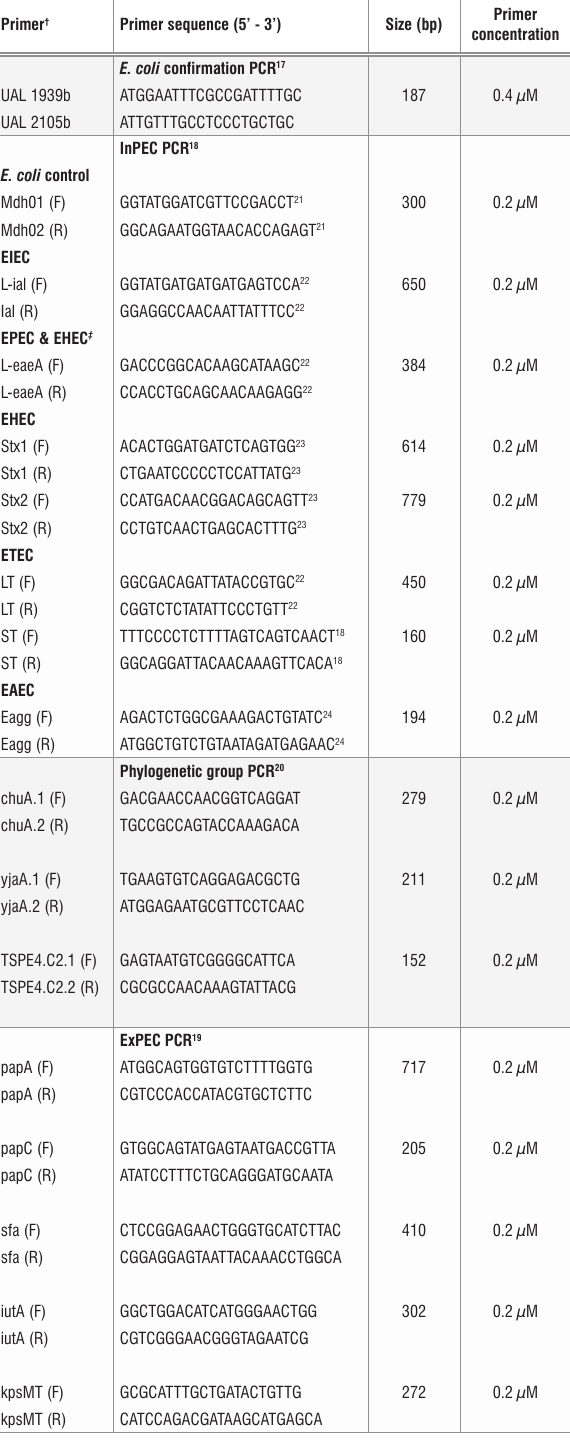
Primer sequences used for uid A, 17 triplex, 20 InPEC 18